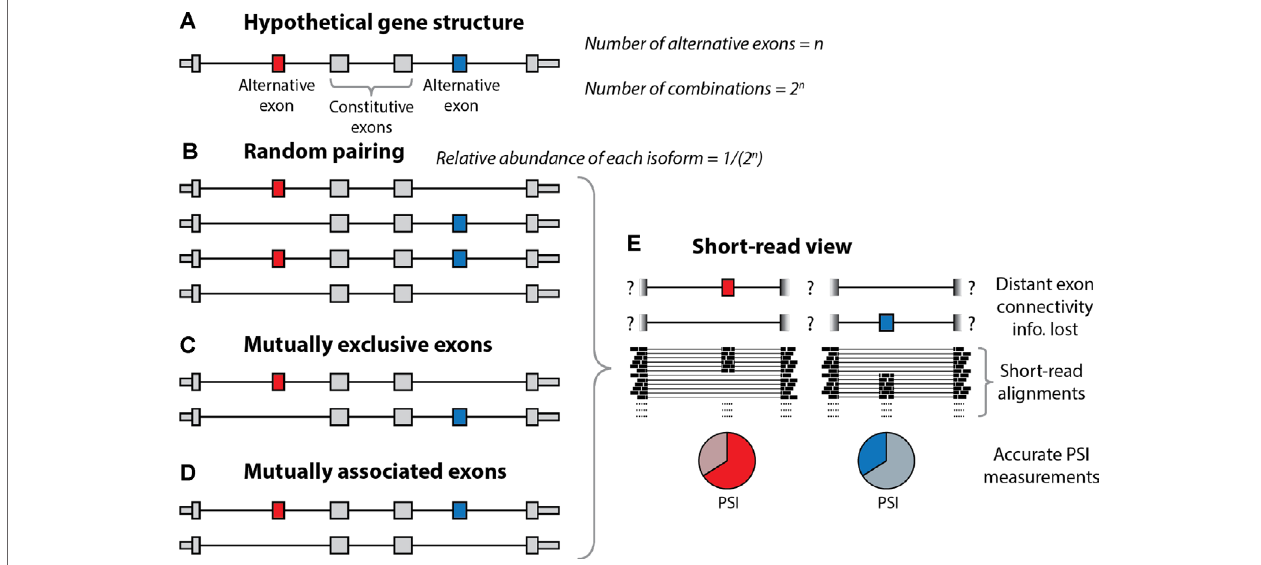
FIGURE 2 | Resolution of alternative splicing events with long-read sequencing. (A) Schematic illustration of the structure of a hypothetical gene undergoing alternative splicing. The gene contains two alternatively spliced exons (red and blue) separated by constitutive exons (gray). In theory, if we let ‘n’ equal the number of alternative exons, then there are 2 n different combinations of these exons. (B) Under random pairing, we would expect to see all of these 2 n combinations, each at a relative abundance of 1/2 n . In this case, short-read RNA-seq would be sufficient, as it can accurately quantify percent spliced-in (PSI) scores for individual exons. (C , D) However, coordinated exon pairing can result in a situation whereby the alternative exons are mutually exclusive (C) or mutually associated (D) . (E) With short-read RNA-seq, these three scenarios are indistinguishable, as the information regarding the connectivity of the alternative exons is lost. Conversely, with long-read sequencing, it is trivial to determine which scenario is